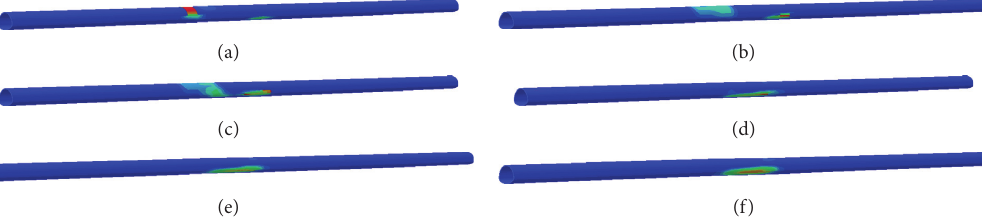
Figure 6: The cloud diagram of the development range of the plastic zone of tunnel lining with different displacements under the coupling fault action. (a) The cloud diagram of plastic zone of 0.1m tunnel lining with coupling fault movement. (b) The cloud diagram of plastic zone of 0.2m tunnel lining with coupling fault movement. (c) The cloud diagram of plastic zone of 0.3m tunnel lining with coupling fault movement. (d) The cloud diagram of plastic zone of 0.4m tunnel lining with coupling fault movement. (e) The cloud diagram of plastic zone of 0.5m tunnel lining with coupling fault movement. (f) The cloud diagram of plastic zone of 0.6m tunnel lining with coupling fault